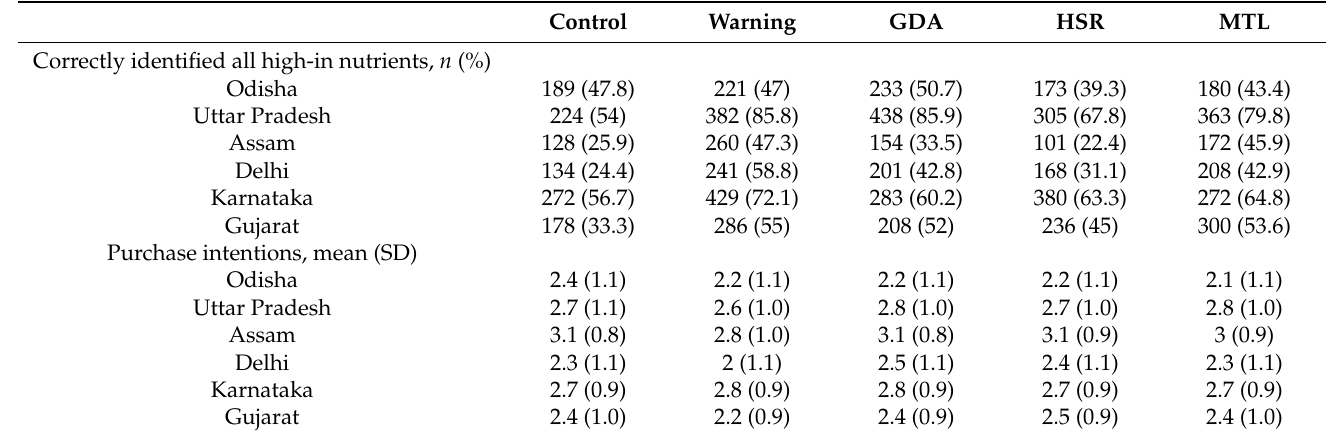
Table A5. Descriptive statistics on the primary outcomes by study arm and state ( n = 14,345).